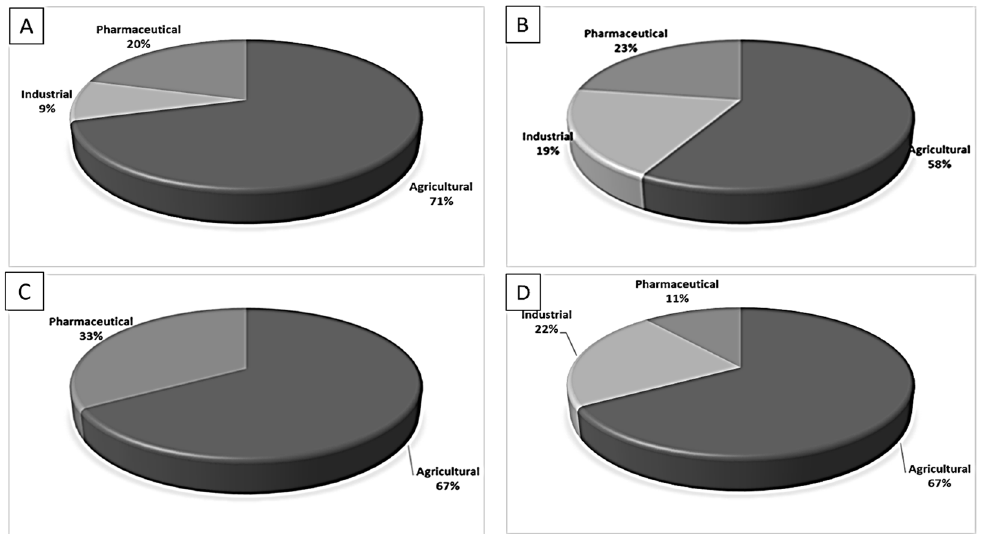
Figure 3. The distribution of potential sources of detected xenoestrogens in: ( A ) tap water, ( B ) open surface water, ( C ) drinking water, and ( D ) vegetables. The percentage in each sector represents the ratio of the overall number of xenoestrogens in a particular sector to the total number of xenoestrogens across all sectors.